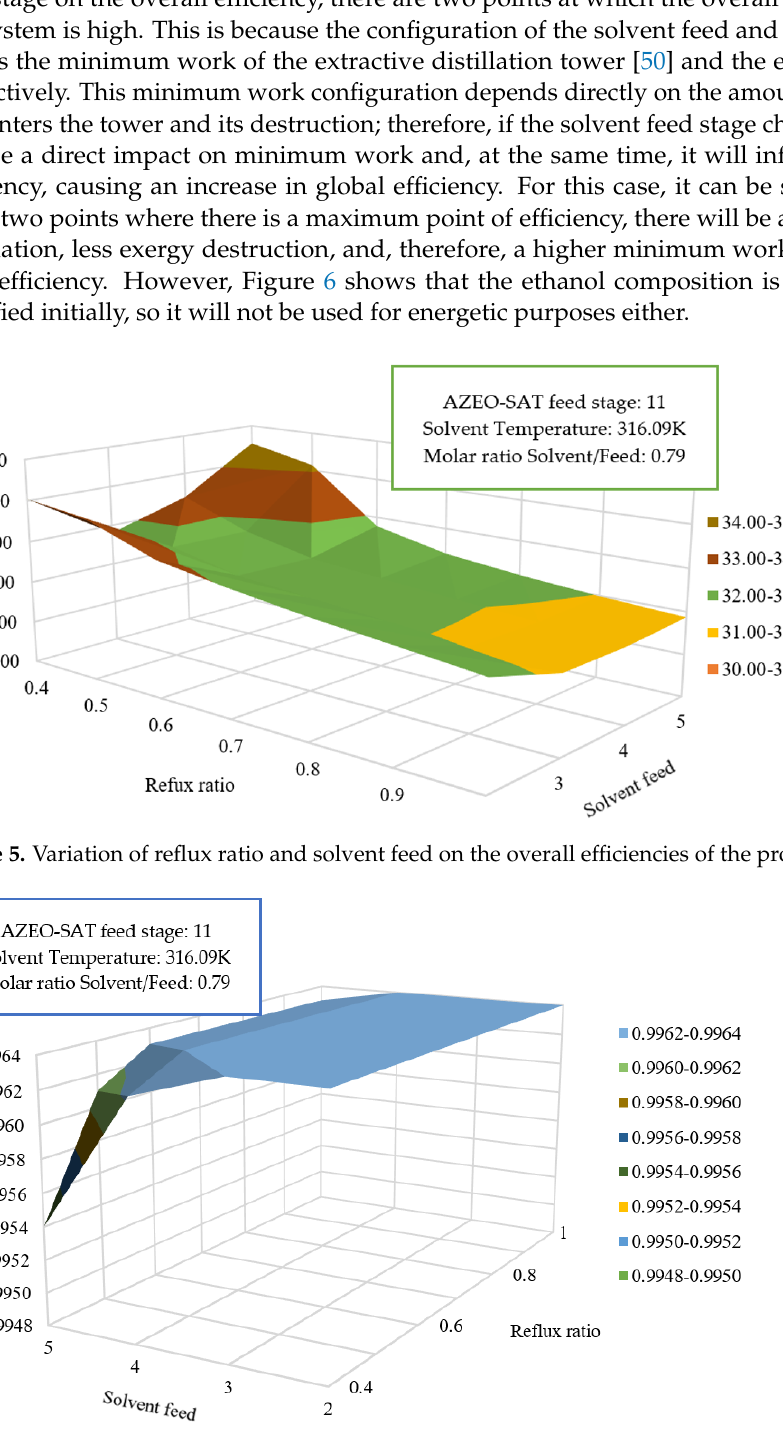
Figure 4. Reflux ratio variation and the number of theoretical stages on the purity of ethanol.